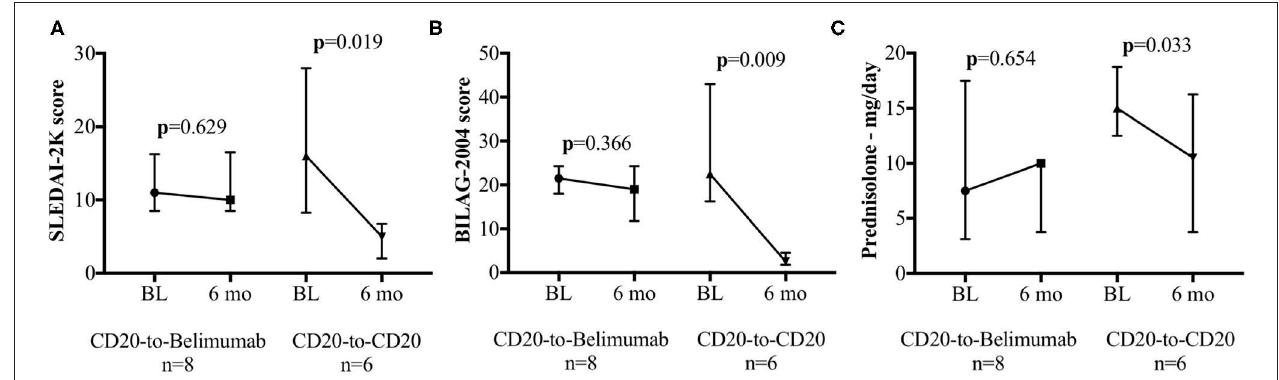
FIGURE 1 | SLEDAI-2K, Global BILAG-2004, and Daily prednisolone dose. Clinical efficacy assessments for the CD20-to-belimumab and the CD20-to-CD20 groups. Each figure shows the pre- and post-treatment results for the (A) SLEDAI-2K, (B) total BILAG score, and (C) daily oral prednisolone requirements in the CD20-to-CD20 group compared to the CD20-to-belimumab group. Points represent median and error bars denote interquartile range. BL, Baseline; 6 mo, 6